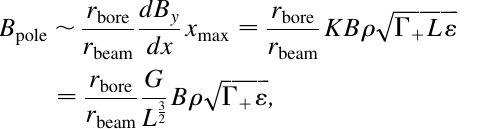
FIG. 3. Normalized beam size calculated by particle